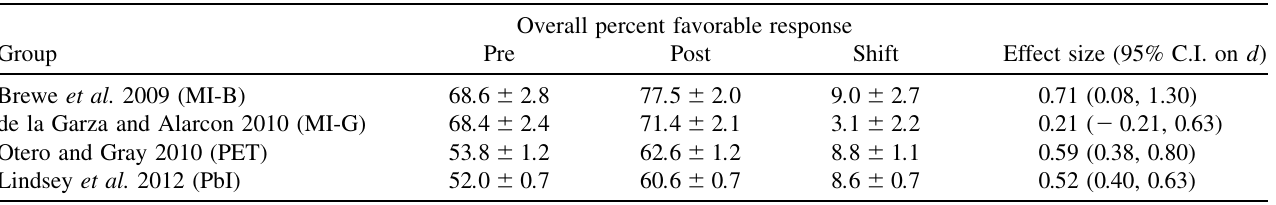
TABLE I. Summary of previously published positive CLASS shifts. Standard errors of the mean are shown in pre, post, and shift data, and the 95% confidence interval (C.I.) on the effect is shown in the effect size. Overall percent favorable response Group Pre Post Shift Effect size (95% C.I. on d